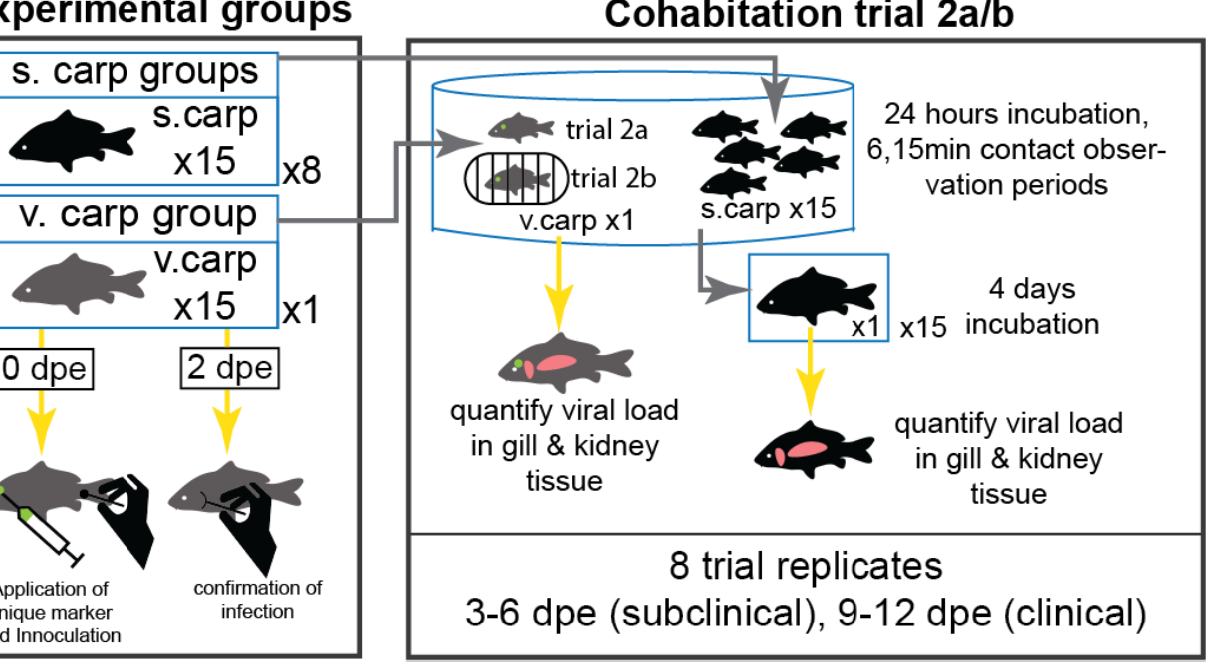
Figure 2. Trial 2a&b schematic. Days post exposure (dpe). Blue lines indicate tank enclosures, numbers within tank enclosures indicate the number of individuals per tank and numbers outside of tank enclosures indicate the number of tanks. Yellow arrows indicate fish movement for inoculation and sampling, and grey arrows indicate movement of fish to new enclosures. Green marks on fish indicate the presence of unique elastomer markings on s.carp. Pink shapes indicate tissue sampling targets of gill and kidney. Vector carp were either cohabitated with sentinel carp in Trial 2a or sequestered in a plastic cage in Trial 2b.